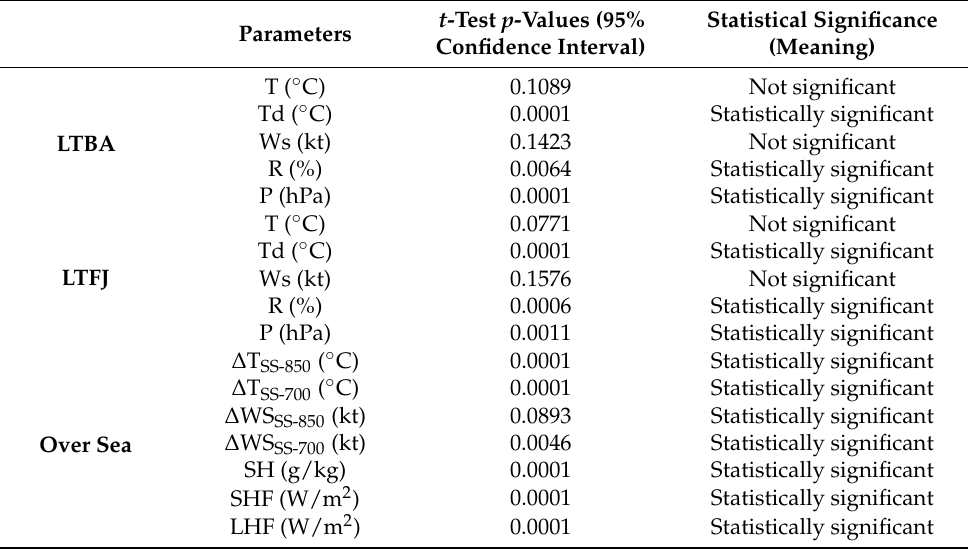
Table 1. The degrees of statistical significance of the data sets analysed in the study for SES and non-SES